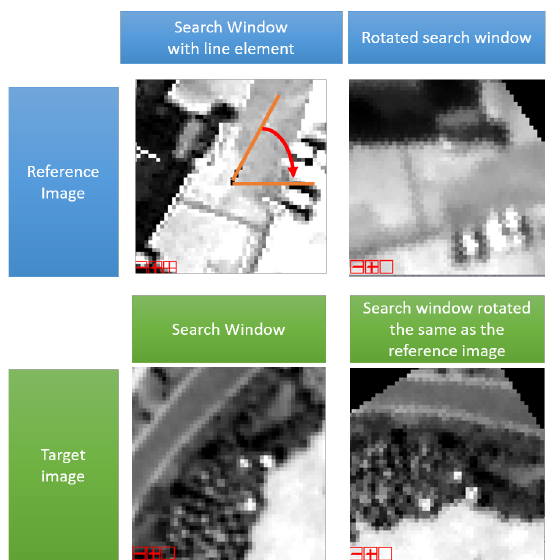
Figure 3. Patch extraction method considering